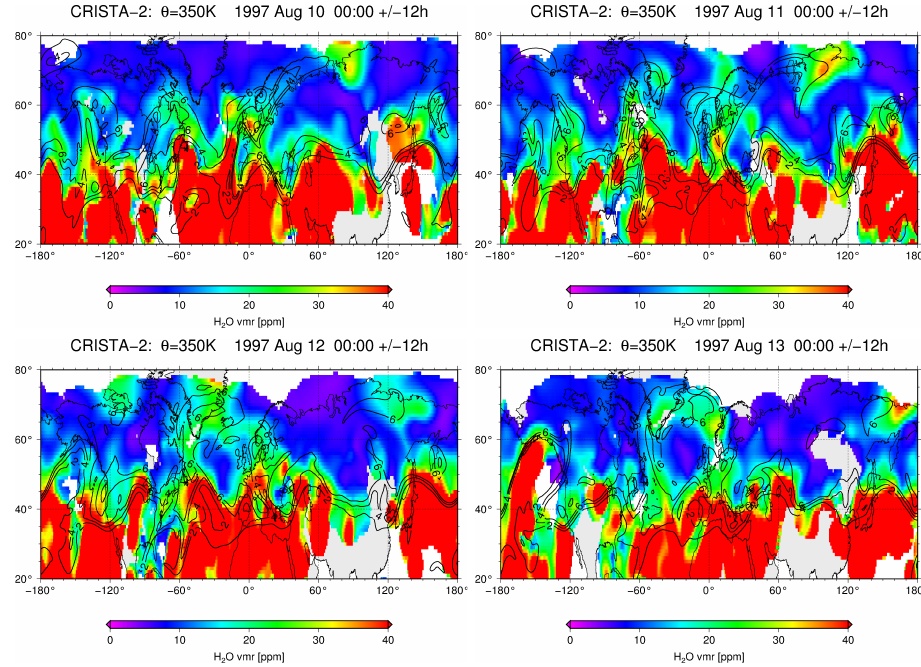
Figure 6. CRISTA 2 measurements of water vapour for 10 to 13 August at 00:00 UTC ± 12h. The asynoptic measurements are interpolated spatially to a regular grid (for details see text). In addition, PV contour lines of 2, 4, and 8 PVU are overlaid in black. White patches in the water distribution indicate data gaps due to